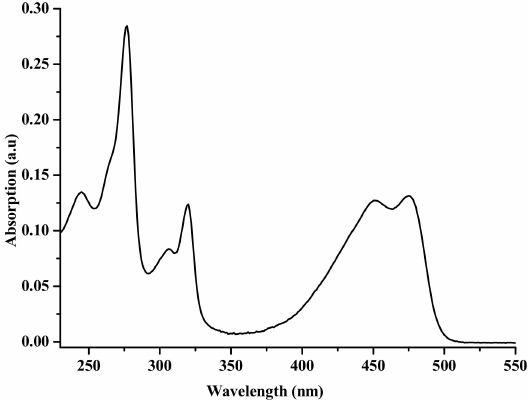
Figure 2. UV-vis absorption spectrum of BPEA in CH 2 Cl 2 (3.66 × 10 − 6 mol /